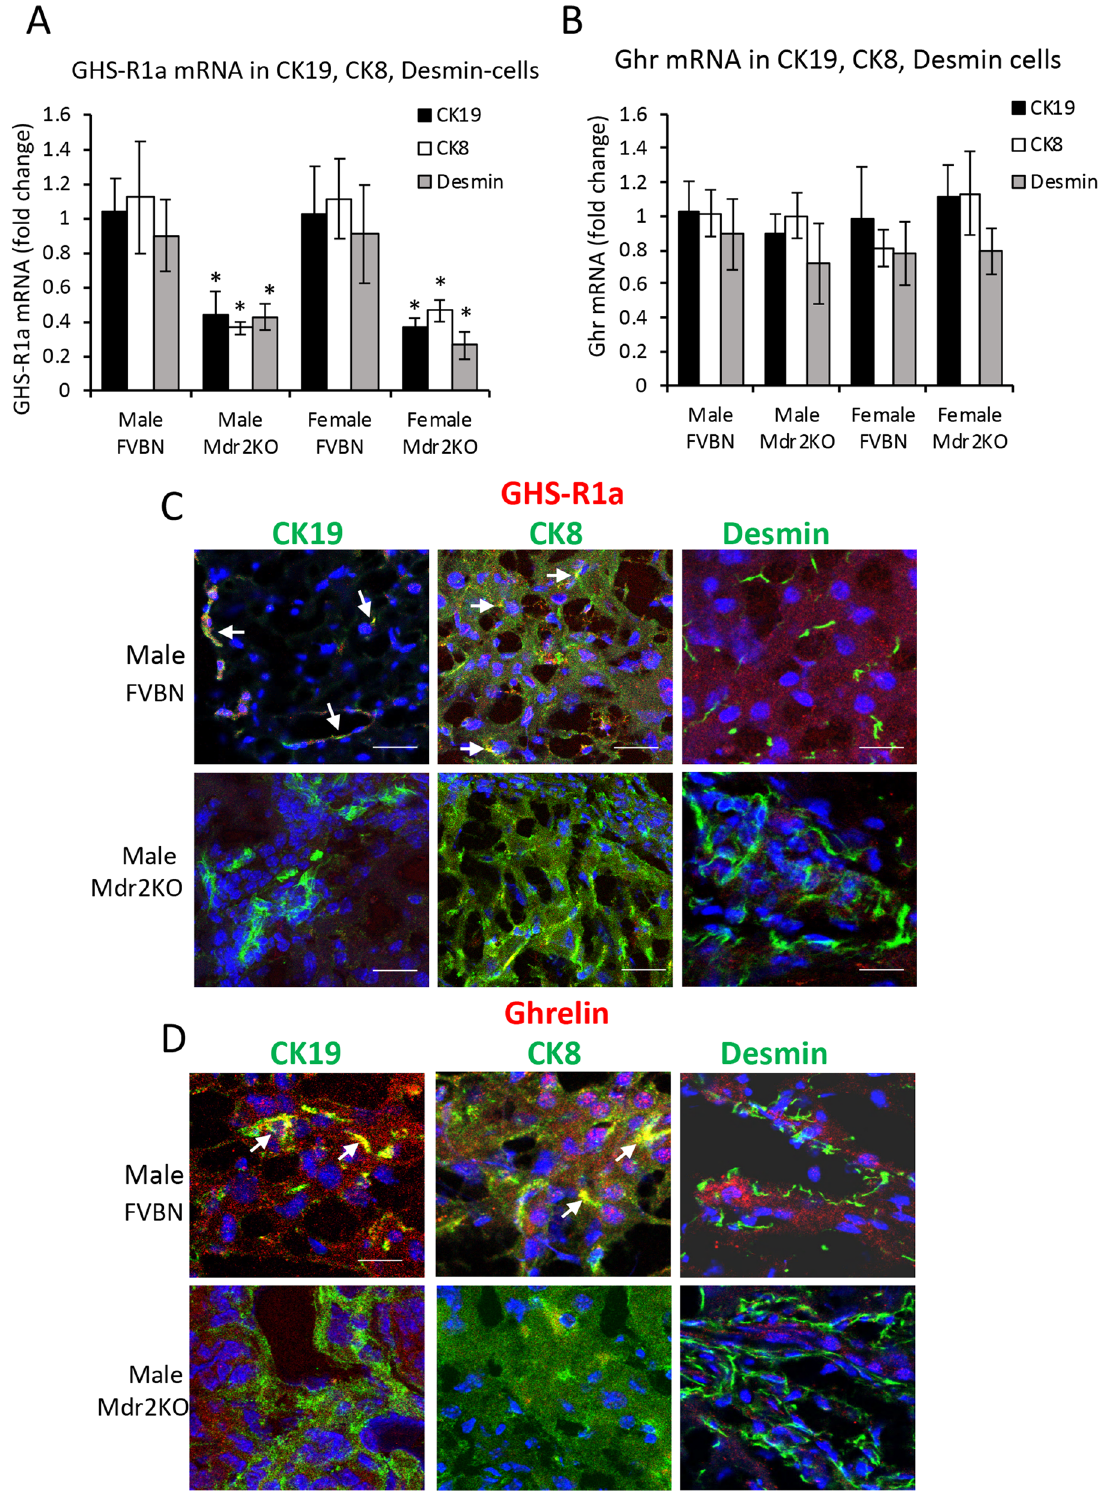
Figure 3. Expression of GHS-R1a and Ghr in liver cells of Mdr2KO vs FVBN mice. (A, B) Liver frozen sections from Mdr2KO and FVBN mice, were immunolabeled for CK19 (cholangiocytes), CK7 (hepatocytes) and desmin (HSC). The labeled cells were dissected by laser capture microdissection (LCM) and used for RNA isolation and quantitative determination of GHS-R1a and Ghr mRNAs (fold change relative to GAPDH gene control). Number of animals for each type of treatment, 4. Number of sample replicates for RT-qPCR assay, 3. p < 0.05. *, Mdr2KO vs FVBN mice. C, D At protein level, GHS-R1a and Ghr were detected in same cell types by confocal microscopy colocalization with CK19, CK8 and desmin. (C) Representative images of GHS-R1a (red) colocalization with cholangiocytes, hepatocytes and HSC (green). (D) Representative images of Ghr (red) with cholangiocytes, hepatocytes and HSC (green). The pixels with both green and red fluorescence signals are shown in yellow (also pointed out by arrows). Cell nuclei were stained with DAPI